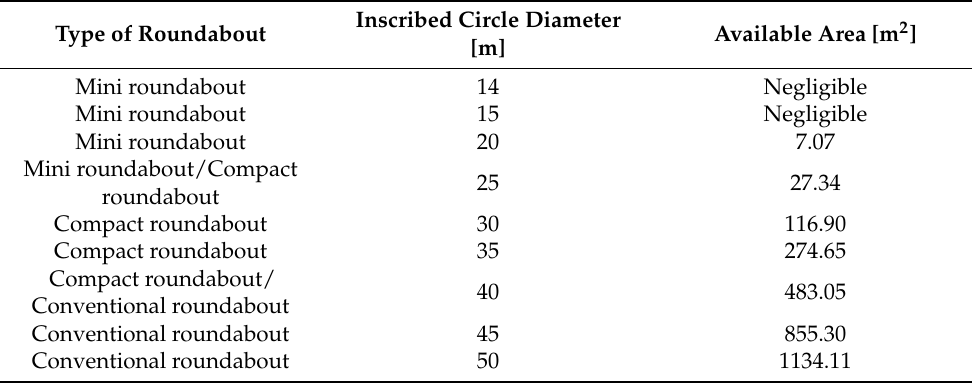
Table 3. Areas available for the installation of the RAPS. Type of